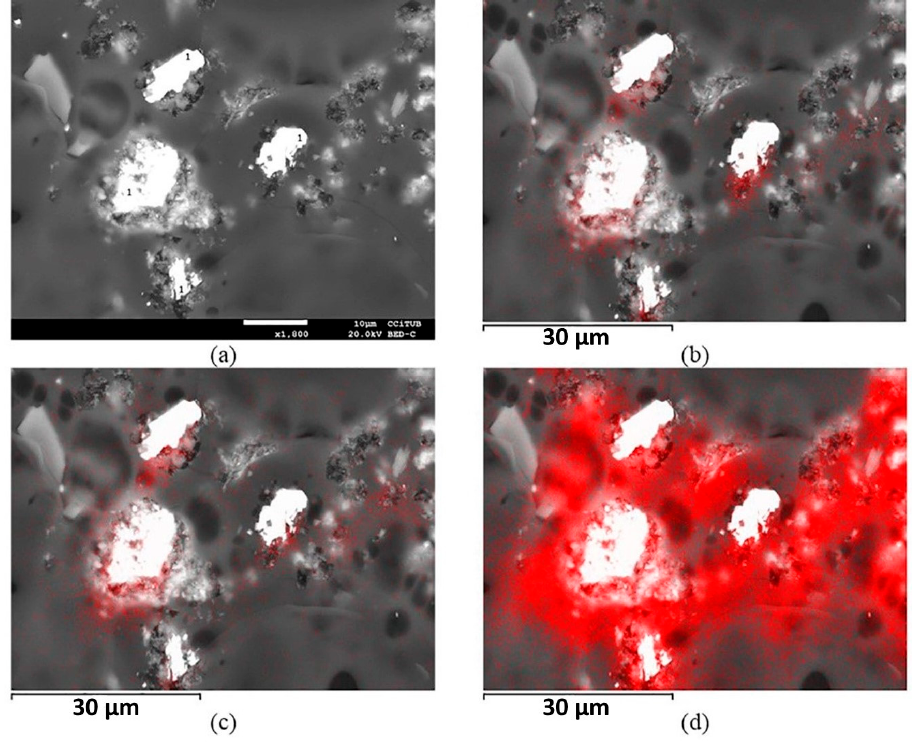
Figure 19. SEM mapping analysis of the leaching residue performed at 70 °C with pretreatment. ( a ) Chalcopyrite particles (1). Elements of interest are shown in red: ( b ) Cu, ( c ) Fe, and ( d ) S [46].